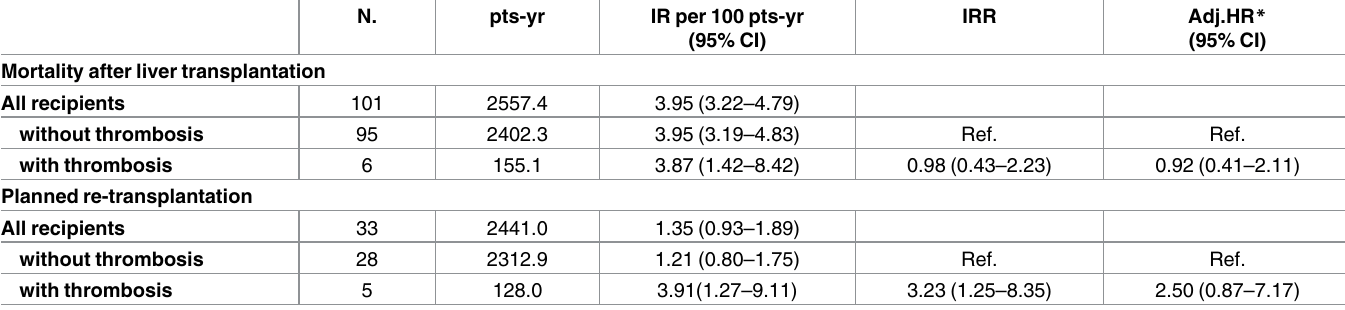
Table 2. Incidence rates of mortality and need of re-transplantation in patients with or without thrombosis.